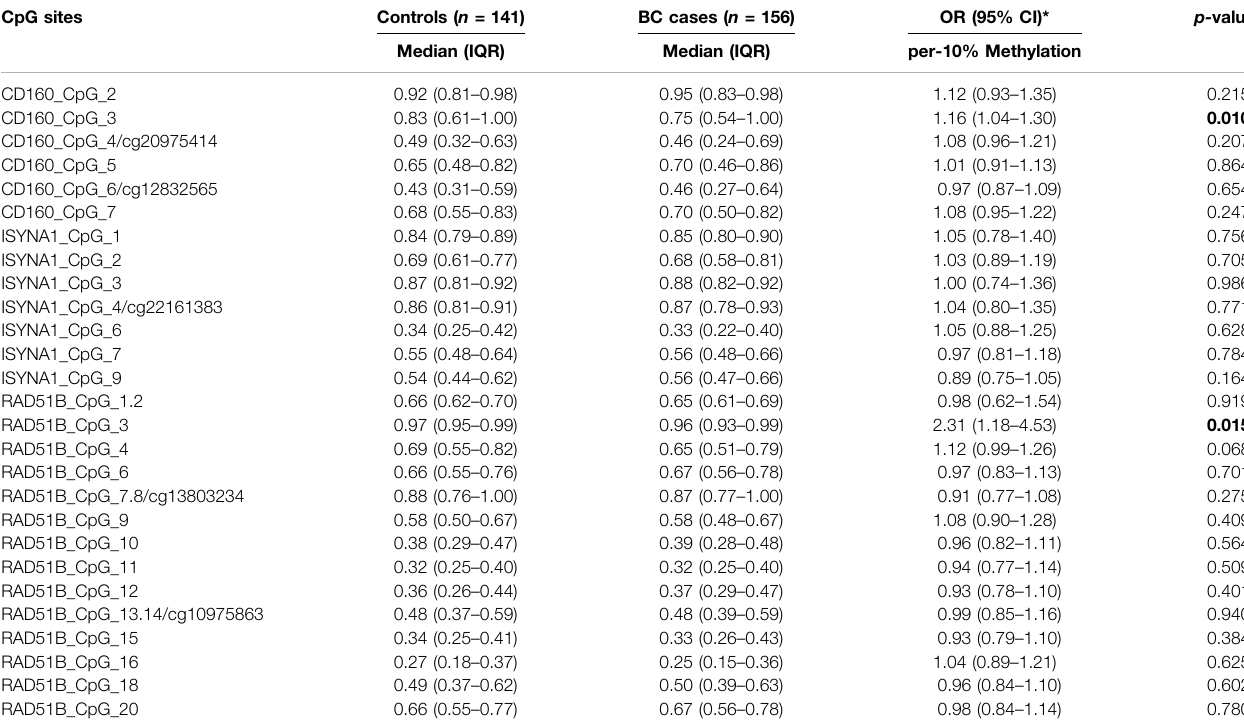
TABLE3| Associationbetweenblood-basedmethylationof CD160 , ISYNA1 ,and RAD51B andBCinsubjectsolderthanorequalto45 yearsoldcombiningvalidationIand validation II. CpG sites Controls ( n = 141) BC cases ( n =